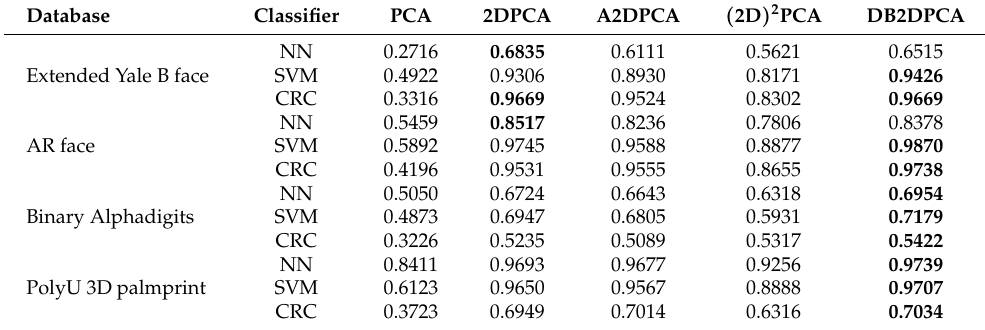
Table 6. The average classification accuracies on four databases by three different classifiers.